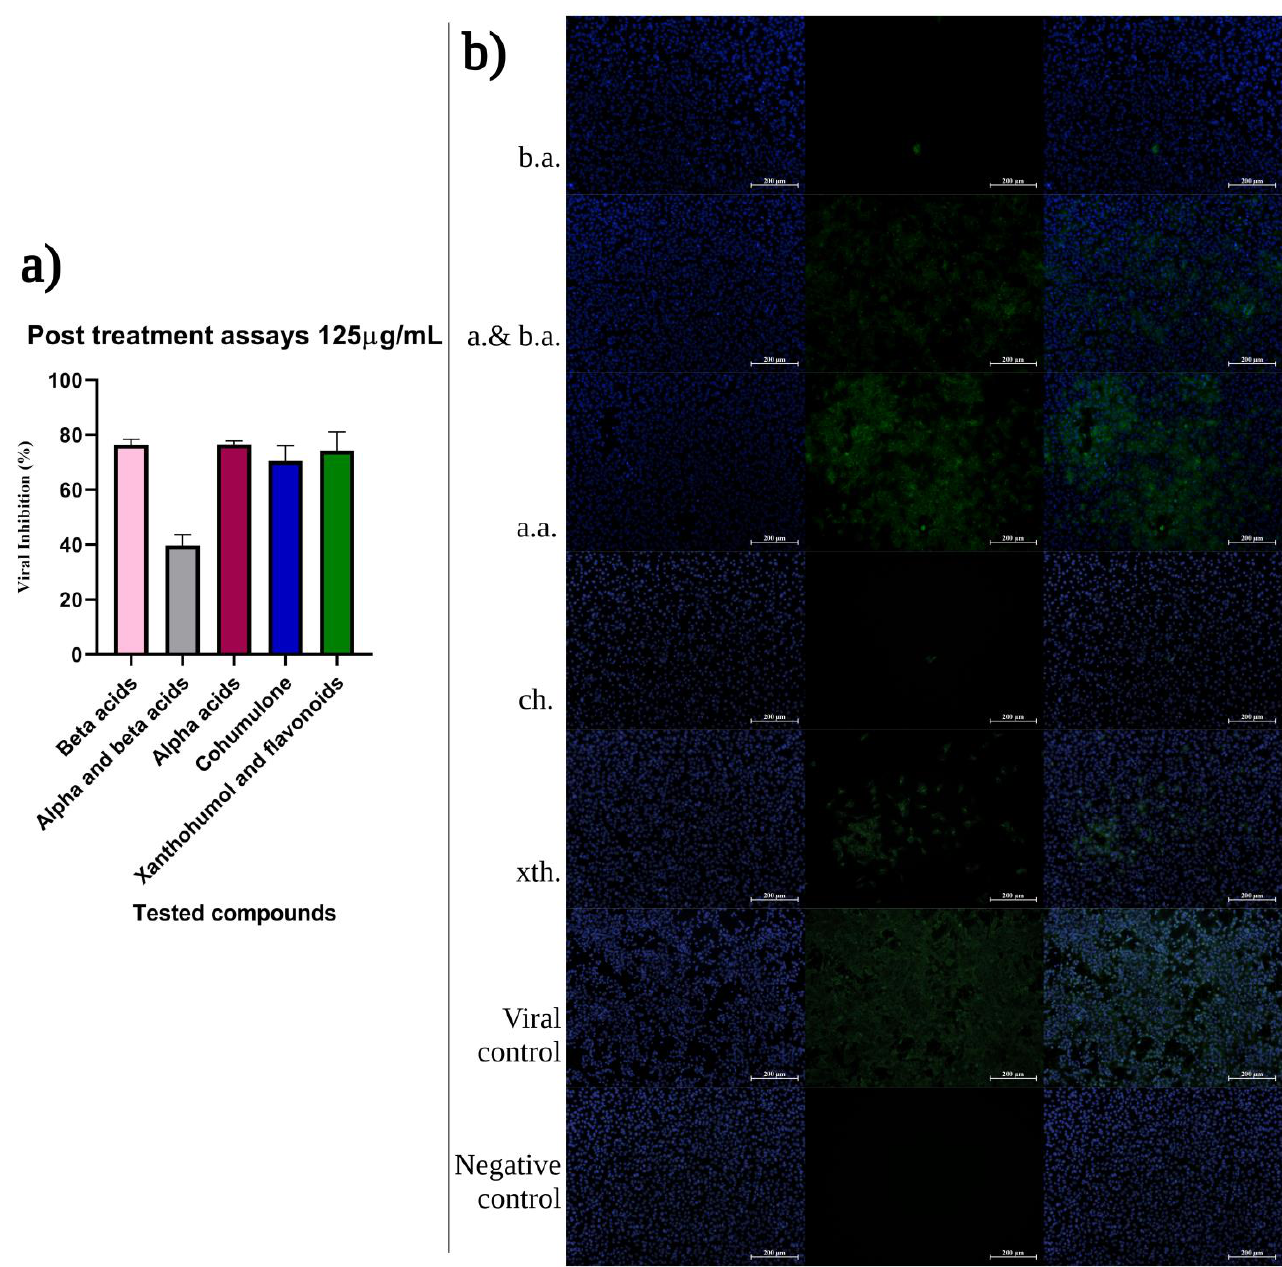
Figure 5. ( a ) Majority of hops compounds protect cells against CHIKV infection. Vero cells were treated independently with 125 µg/mL at MOI 0.1 for 1 h, in agitation. The virus-containing medium was removed and replaced with the compound solubilized in 1% carboxymethyl cellulose (CMC). Infected cells were incubated for 48 hpi. ( b ) Immunofluorescent images of CHIKV-infected Vero cells under post-treatment condition with the compound of interest at 125 µ M. The cells were challenged with MOI = 0.1 of CHIKV. Negative control corresponds to cells not infected by the virus, and CHIKV-infected cells without compound were used as positive control. The CHIKV was detected by IFA, with CHIKV MIAF antibody stained with 488 ALEXA antibody and then stained with DAPI to visualize nuclei (blue). Images are representative of three independent experiments. Scale bars are 200 µm. ( abb . b.a. — β -acids ; a and b.a — α -and β -acids; a.a. — α -acids; ch. — cohumulone; xth. — xanthohumol and flavonoids). Visual sensitivity was increased to shallow contrast by Adobe Photoshop 2021.